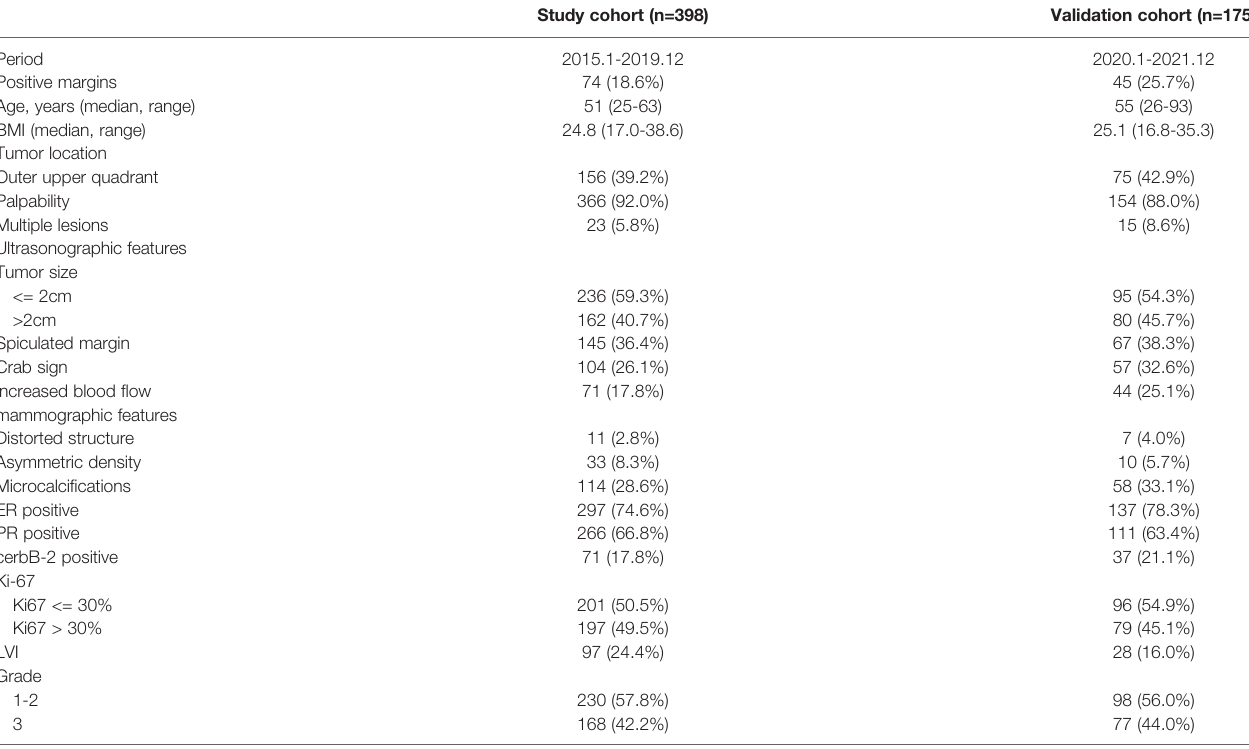
TABLE 1 | Patient demographics and clinicopathologic characteristics in the study and validation